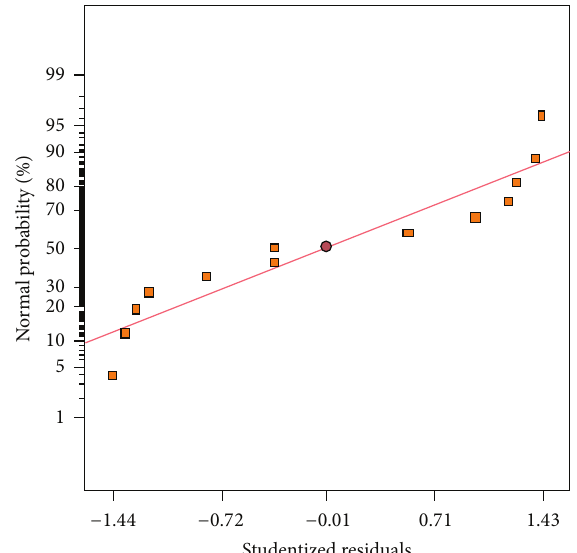
Figure 11: Normal probability of studentized residuals for GLA con-